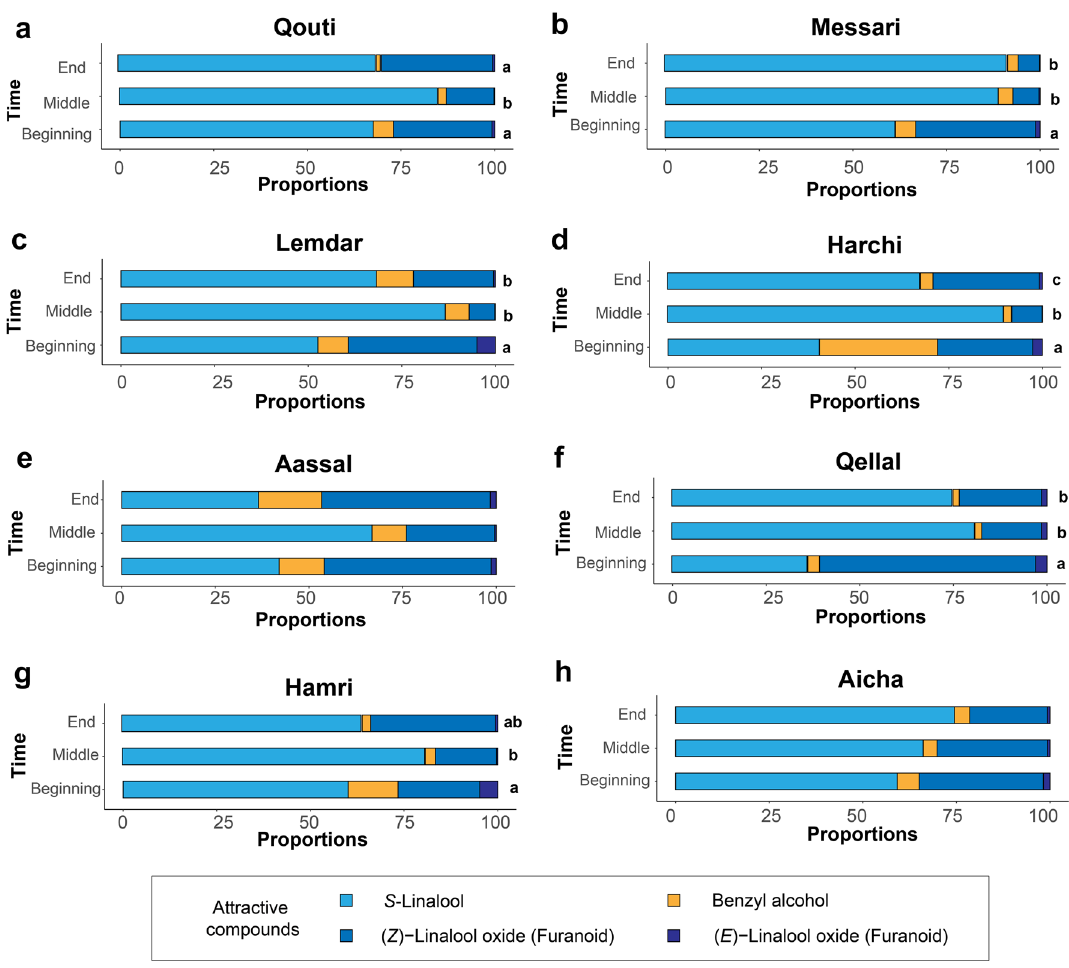
Figure 5. Relative proportions of the four pollinator-attractive volatile organic compounds (VOCs) at the three different time within the manual pollination period of the eight varieties ( a , b , c , d , e , f , g and h ). Results of pairwise comparisons between times were performed with correction of p -values using the “fdr” procedure. Different letters indicate statistically significant differences. When no letter is indicated, the global test was not statistically significantly